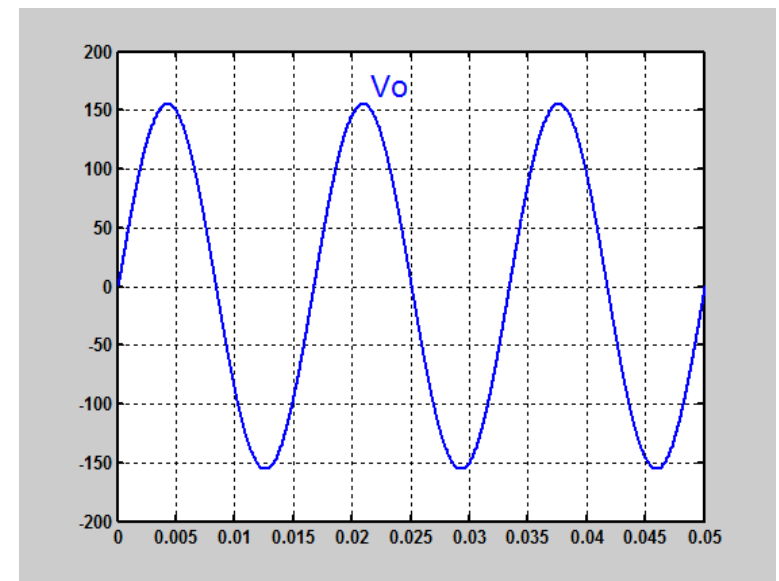
Figure 6. Simulated waveforms in response to the inductor capacitor (LC) variation for the modified control technology (50 V/div).